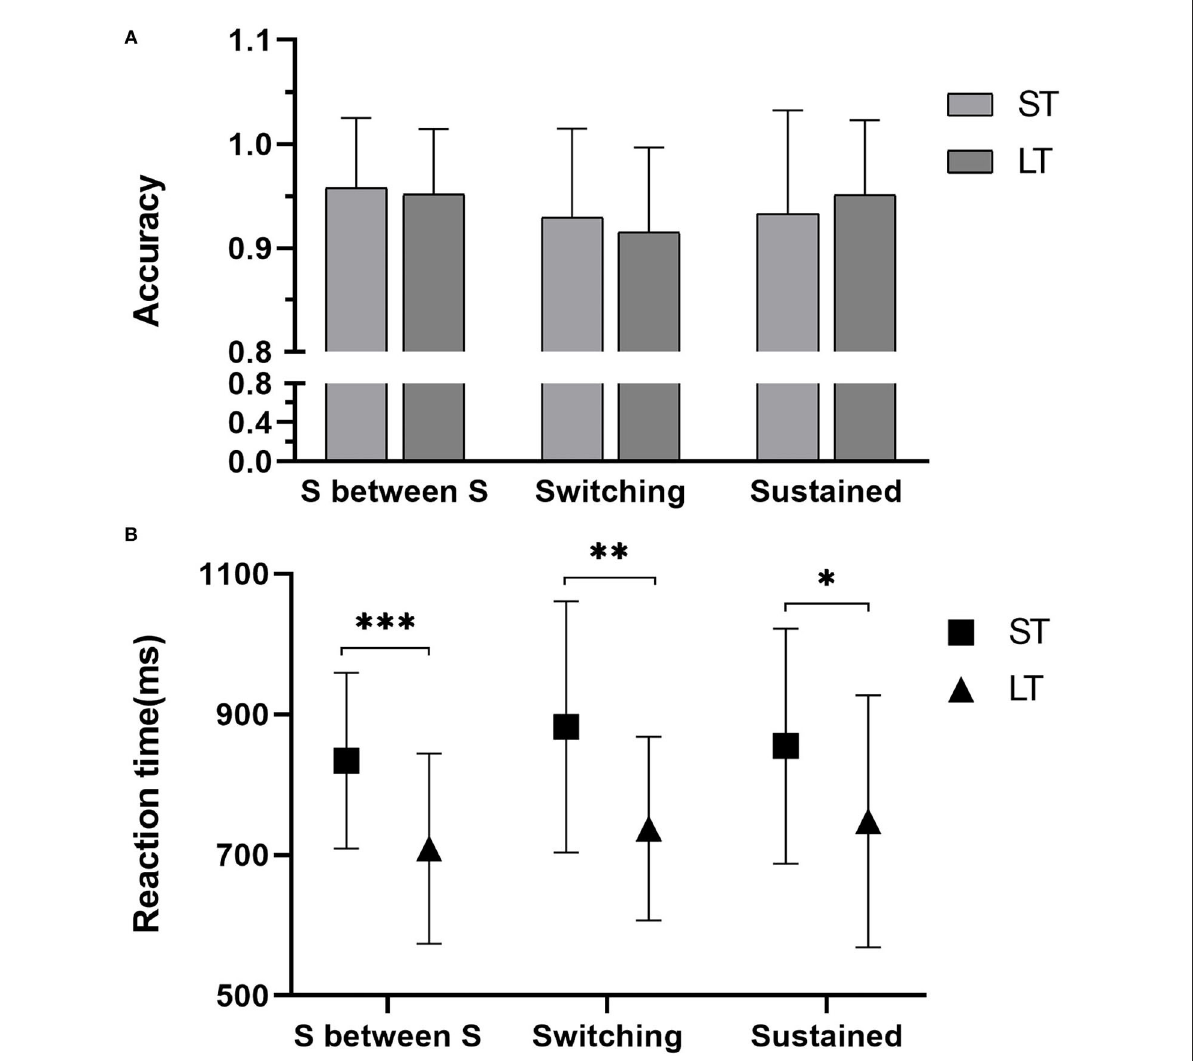
FIGURE3 Results of the Switching task. (A) The accuracy of three blocks and (B) the reaction time of three blocks. ST, the short-term group; LT, the long-term group; S between S, Sustained between Switching block, * statistically significant with P < 0.05, ** statistically significant with P < 0.01, *** statistically significant with P <